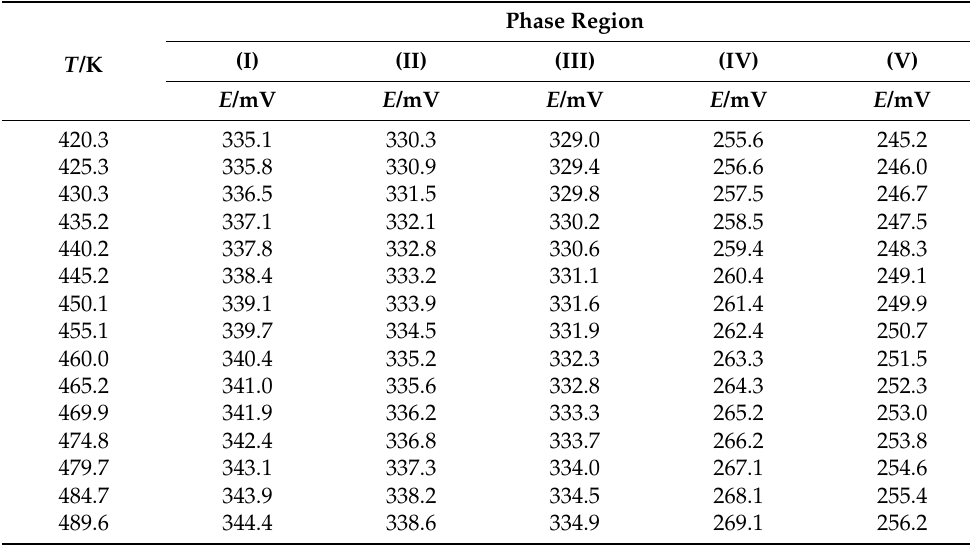
Figure 4. XRPD pattern of the sample with the nominal composition AgIn 5 Te 8 . Compositions of the sample and identified phase (with space group indicated) are shown in the upper-right corner. The measured E vs. T values are compiled in Table 1 and plotted in Figure 5. Table 1. A summary of the measured EMF values and temperatures of the GCs in different phase regions of the Ag–In–Te system.